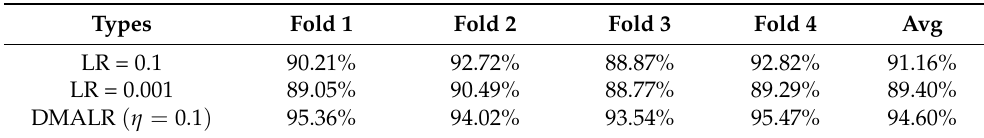
Table 5. Accuracy of different LR strategies in four-fold